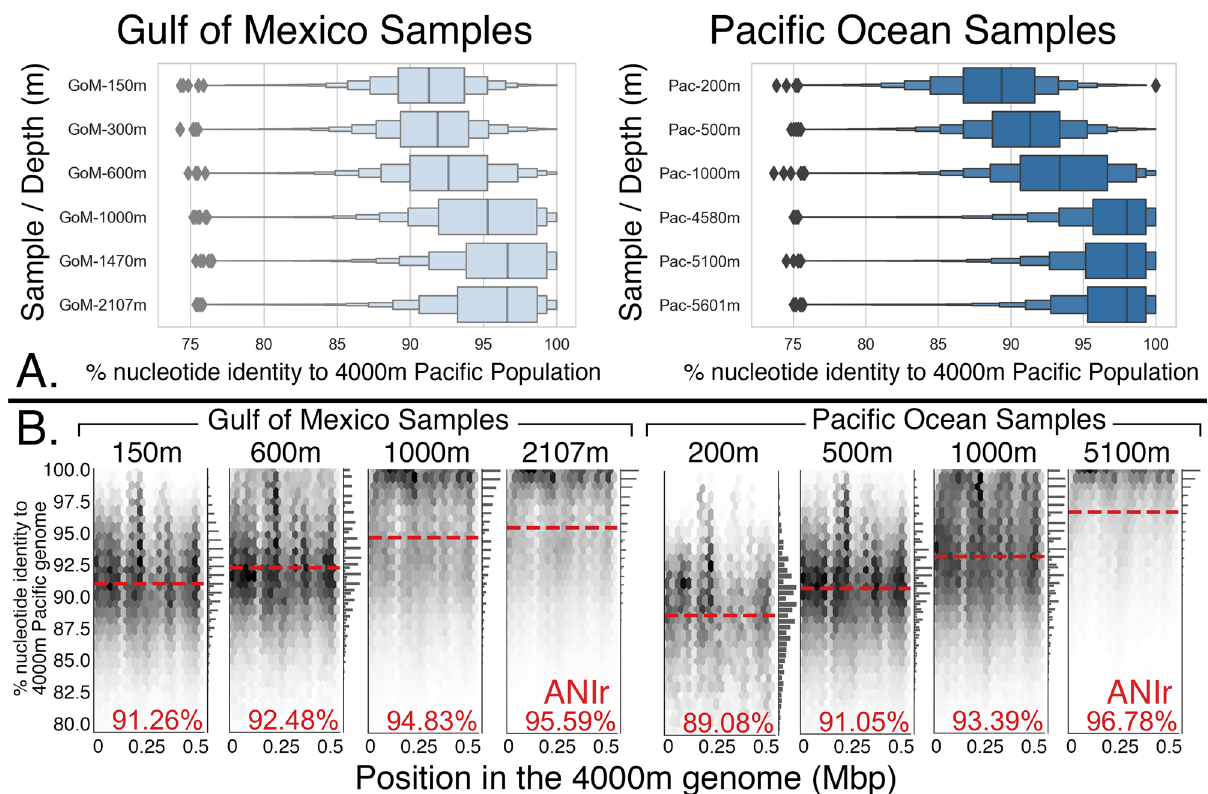
Fig. 2 Biogeography of sequence-discrete Thaumarchaeota Group I populations. A reference genome representing the thaumarchaeotal population at 4000-m depth in the Paci fi c Ocean was queried against the previously described metagenomes from six different depths of the Paci fi c Ocean 29 and the Gulf of Mexico (our unpublished data). A Range in nucleotide identities between the metagenomic read sequences and the genome, represented as letter- value plots 30 , and their vertical line the median (x axis), plotted against the depth that the metagenomic sequences were recovered from (y axis). B Read recruitment representation for selected comparisons performed [the uppermost box-plot in the panel A represents the distribution of sequence identity values of the reads against the reference genome shown in the leftmost plot in the panel B . The plots in panel B are similar to the low, left panel of Fig. 1 but the data points (representing mapped reads) have been binned into a positional, hexagonal heatmap for demonstration purposes. Note that Thaumarchaeota are genetically distinct between different depths of the same water column ( A ) but genetically more similar across similar depths in geographically distant locations ( B ), and that if representative genomes or whole-populations from all depths are compared, they will show a range of ANI values between 89 and ~100% among themselves. Note also that the use of short Illumina reads tends to overestimate nucleotide identity (and thus ANIr values) compared to longer Sanger reads or whole/partial genomes used in our previous publications, especially for moderately identical sequences (e.g., in the range of 80 – 95% nucleotide identity), mostly due to inability of current read mapping algorithms to align such short sequences. Further, the mapping of metagenomic reads to the reference genome was performed with MegaBLAST, in contrast to Blastn in Fig. 1, and MegaBLAST is even less sensitive (but much faster) in fi nding reads of intermediate identity (e.g., in the range of 70 – 90% nucleotide identity) compared to Blastn 31 . Therefore, the ANIr values shown are higher than our previous estimates for similar samples (or even Blastn-derived estimates based on the same metagenomic reads) due to this technical limitation, but the diversity patterns across depths remain